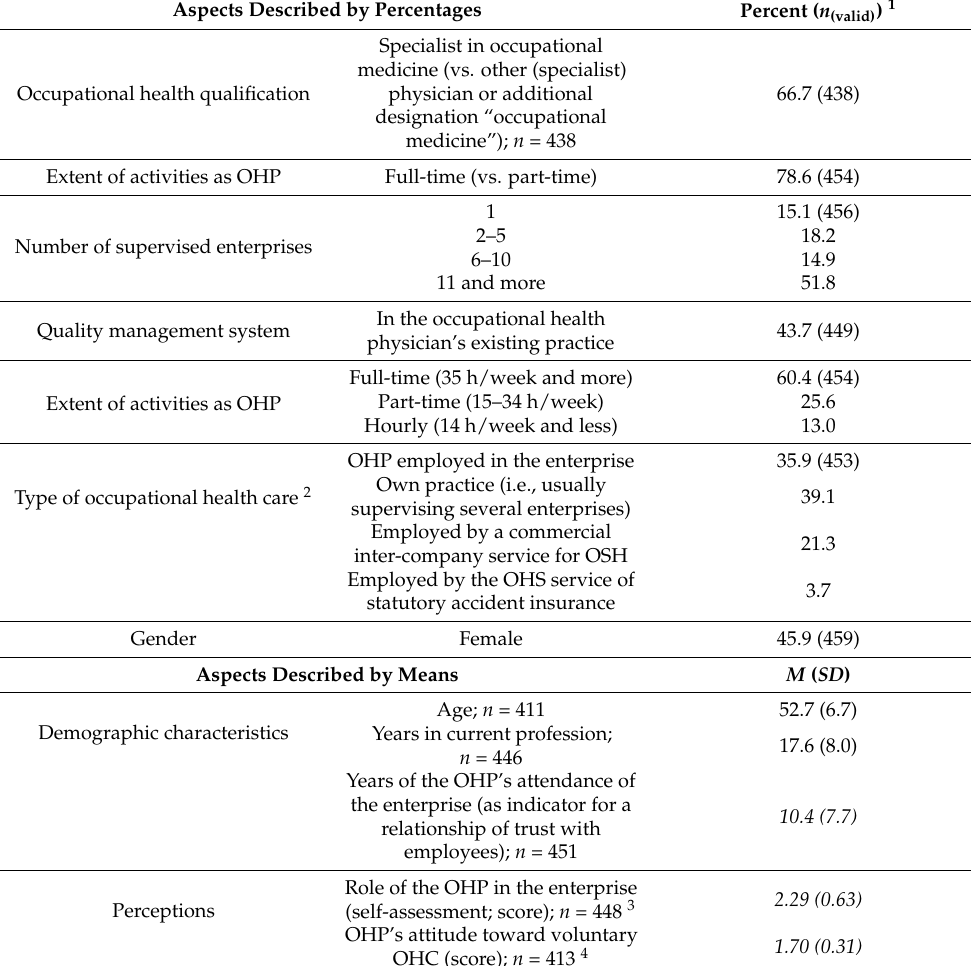
Table 1. Characteristics of occupational health physicians